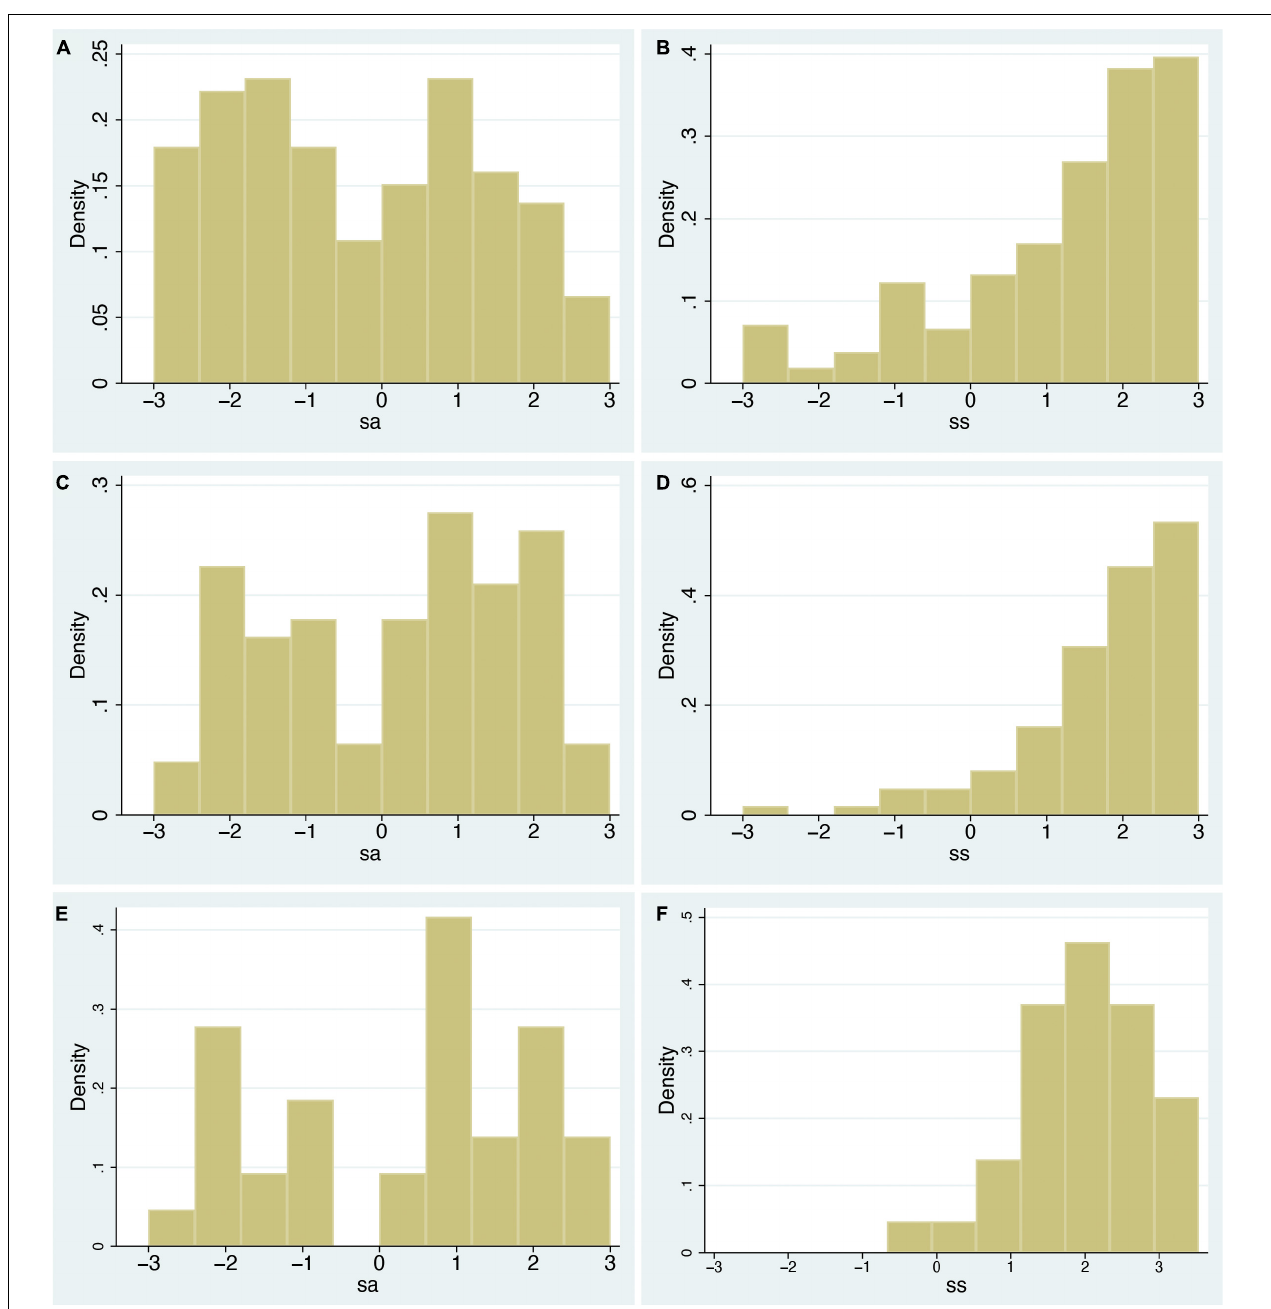
FIGURE 2 | Histograms of the sa and ss variables for varying levels of swash . (A,B) For all 353 individuals, (C,D) for those with swash > 2 ( n = 103), and (E,F) for those with swash > 2.64 ( n = 36). The x-axis shows the ordinal scale of the seven-point scale for the questionnaire responses (from –3 to +3), and the y-axis shows the empirical probability